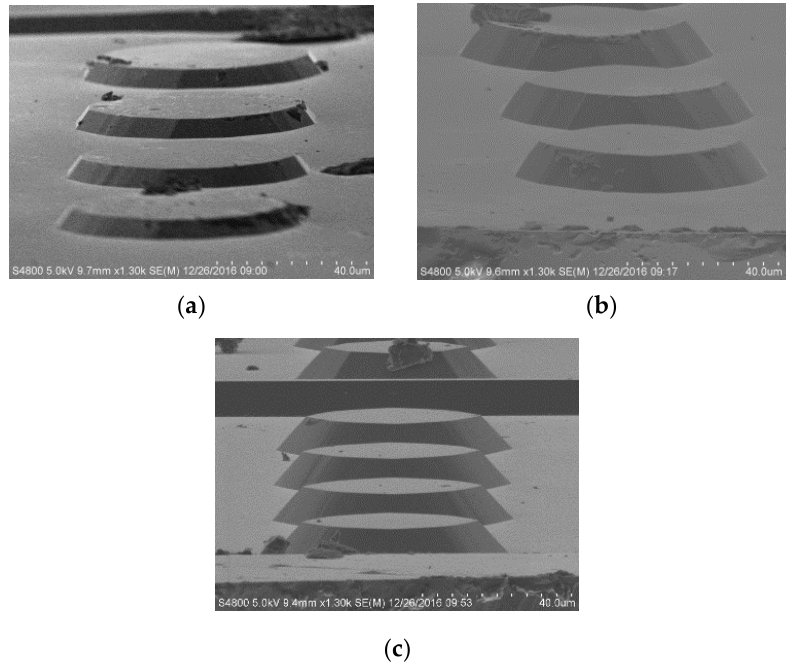
Figure 3. Shape of circular mesas in Tetramethylammonium hydroxide (TMAH) + Triton-X-100 solution after different etching times: ( a ) 40 min; ( b ) 50 min; ( c ) 60 min.